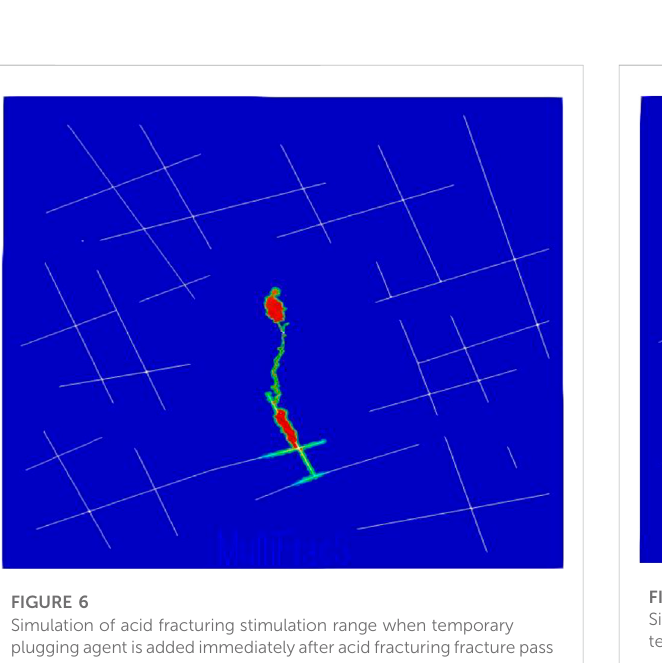
FIGURE 7 Simulation of stimulation acid fracturing range by adding temporary plugging agent after injecting 100 m 3